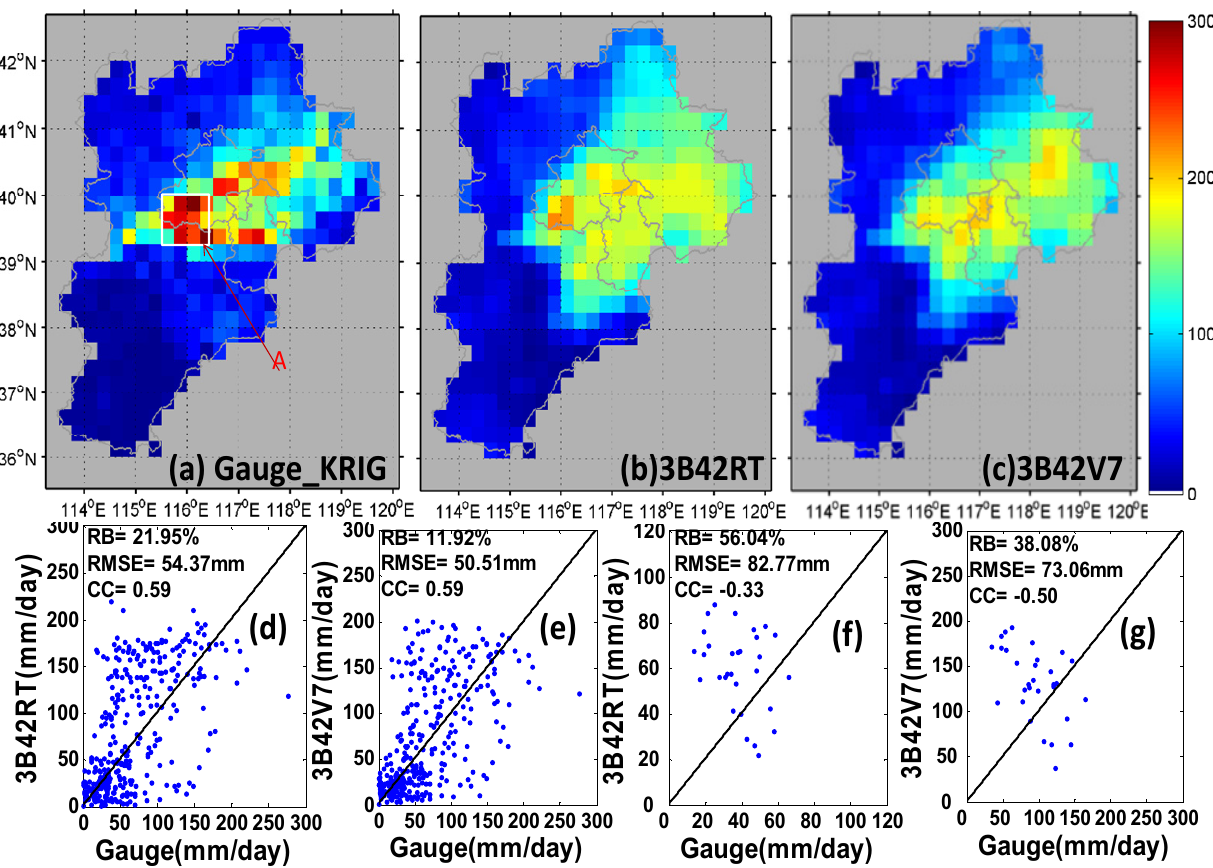
Figure 2. ( a ) Gauge accumulation based on Kriging interpolation (Guage_KRIG); ( b ) 3B42RT accumulated rainfall; ( c ) 3B42V7 accumulated rainfall; ( d – g ) Scatter plot of gauge vs . 3B42RT/3B42V7 accumulated rainfall over Hebei, Beijing and